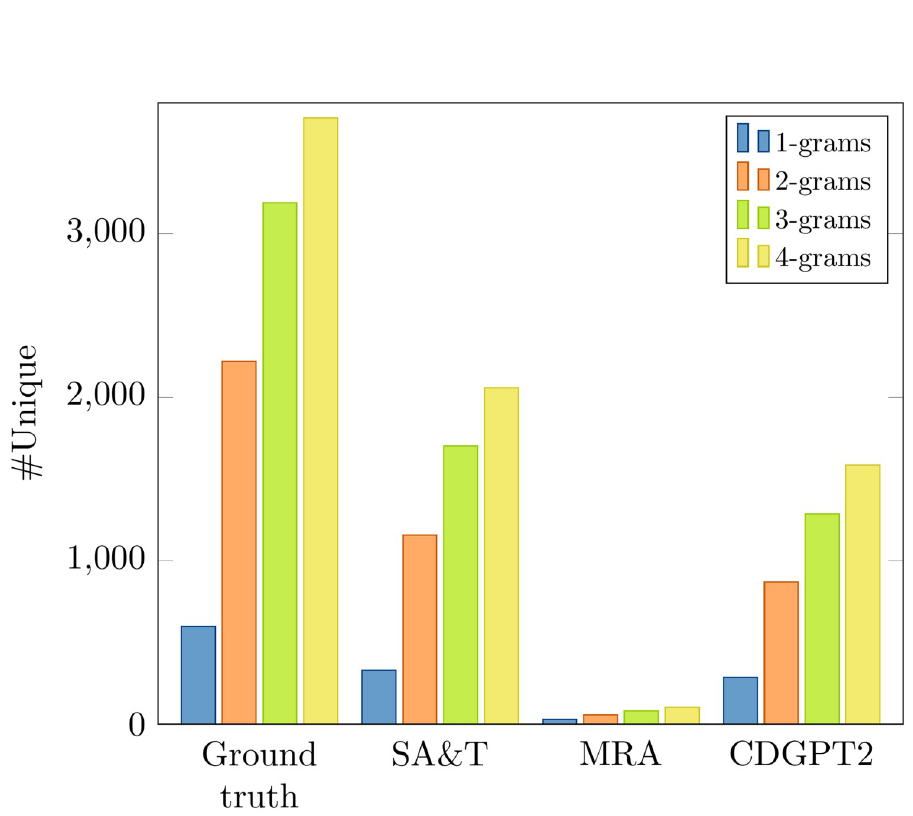
Fig 7. Number of unique n-grams in reports generated by SA&T, MRA, CDGPT2 and in ground truth reports for the IU chest X-ray data. Although reports generated by MRA are longer than those generated by SA&T and CDGPT2, they are more similar to each other. Average length of reports generated by SA&T is 32, by CDGPT2 is 32, and by MRA is 47.